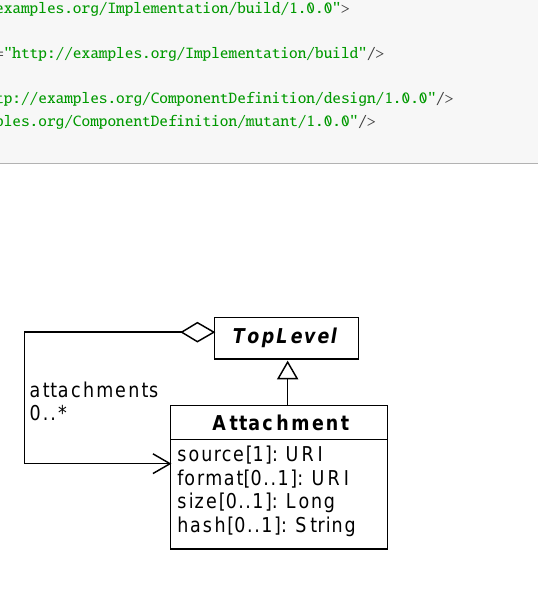
Figure 23: Diagram of the Attachment class and its associated